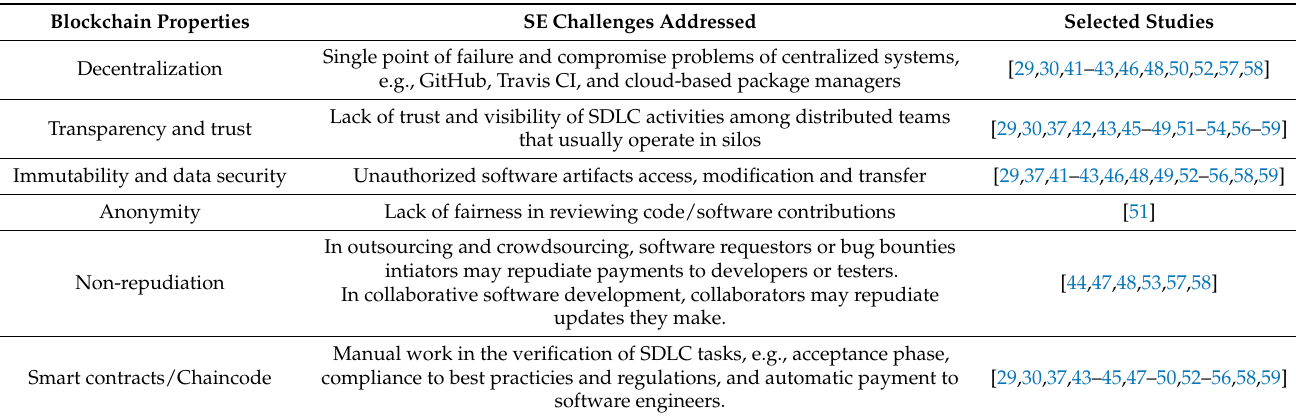
Table 6. Mapping of blockchain properties and SE challenges